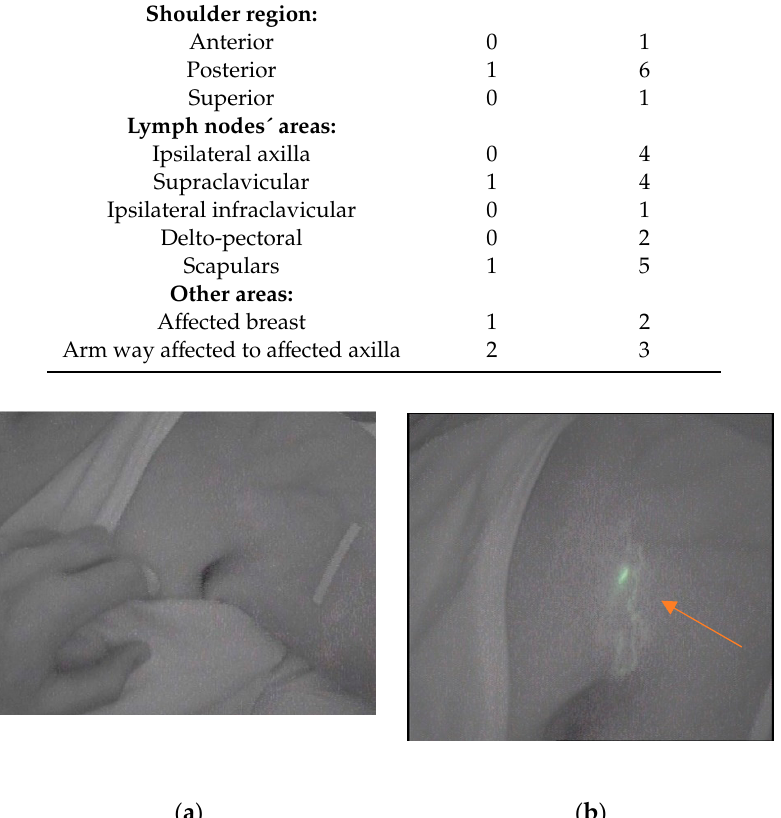
Figure 2. ( a ) Anterior vision of the affected shoulder (pretest); ( b ) Pathway from the shoulder to the clavicular lymph node (posttest).